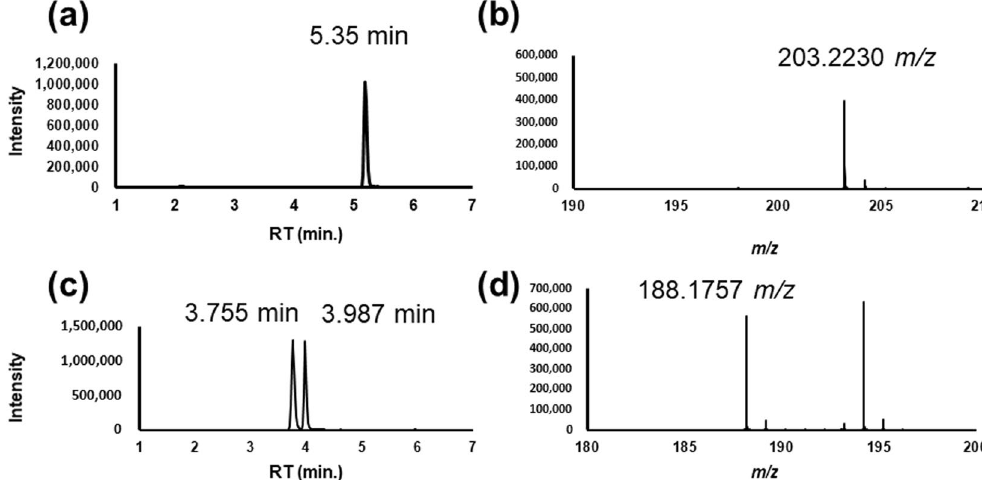
Figure 2. Examples of extracted ion chromatograms (EIC) and mass spectra. ( a ) EIC (203.2230 m/z ) and ( b ) mass spectrum (5.35 min) of spermine. ( c ) EIC (188.1757 m/z ) of N 1 -acetylspermidine (3.755 min) and N 8 - acetylsperimidine (3.987 min). ( d ) Mass spectrum (188.1757 m/z ) of N 1 -acetylspermidine (3.755